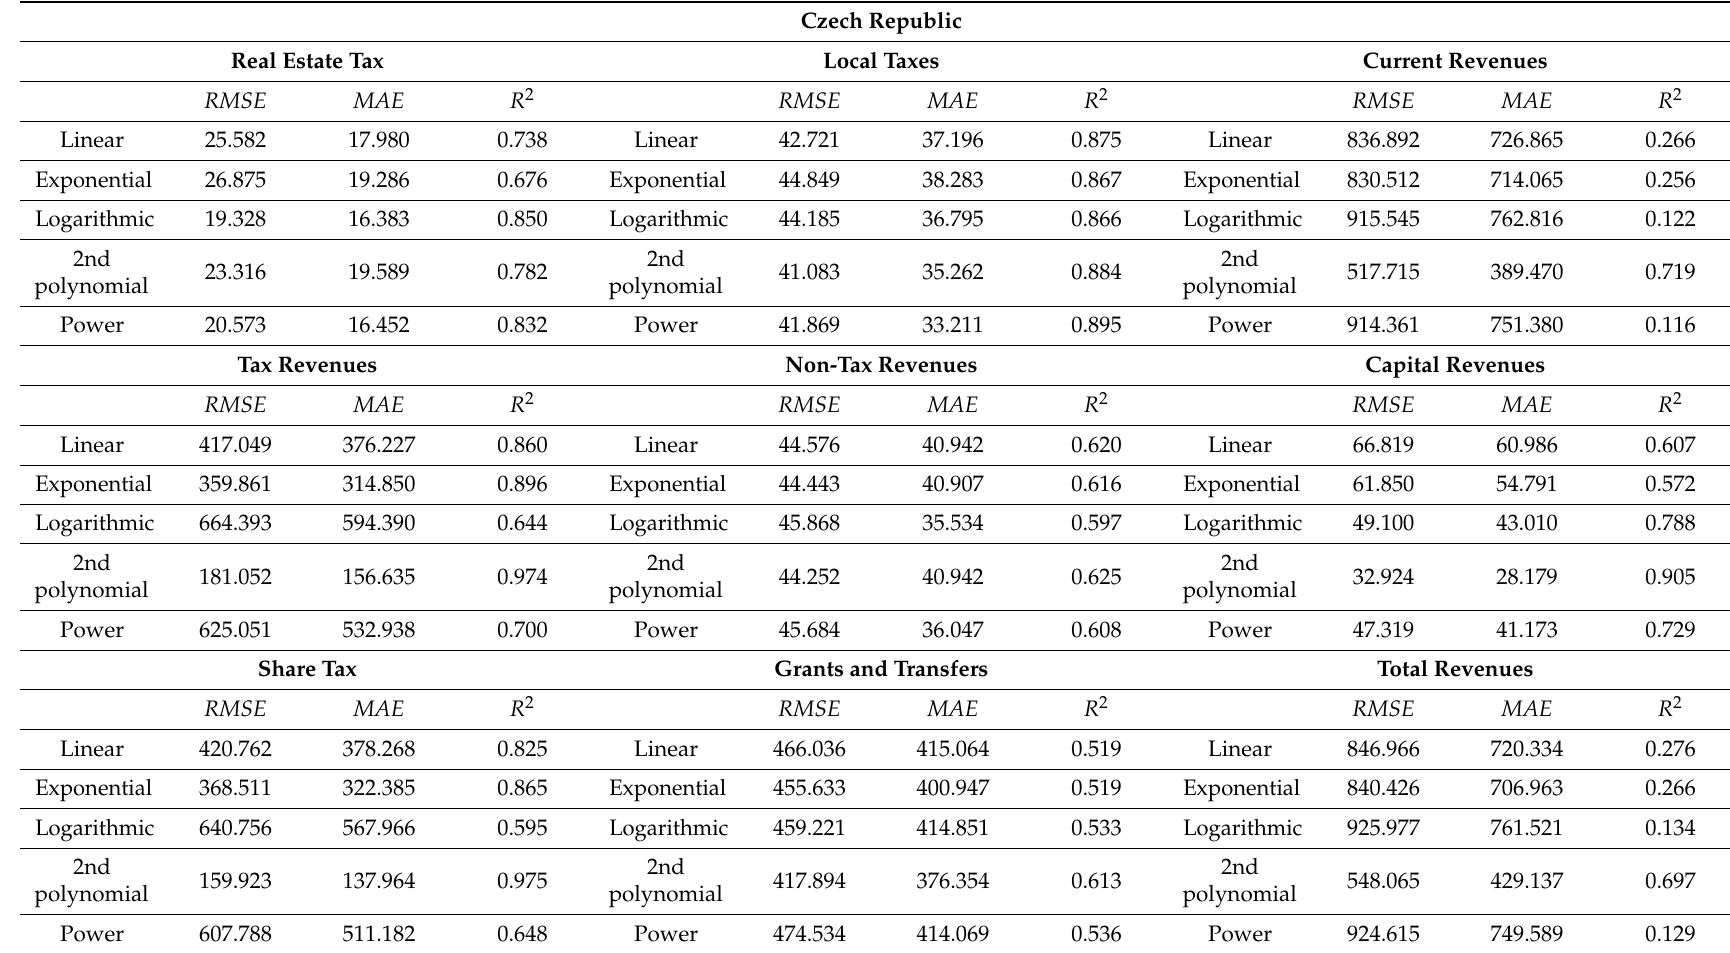
Table 8. Trend functions of selected revenues of the municipalities in Czech